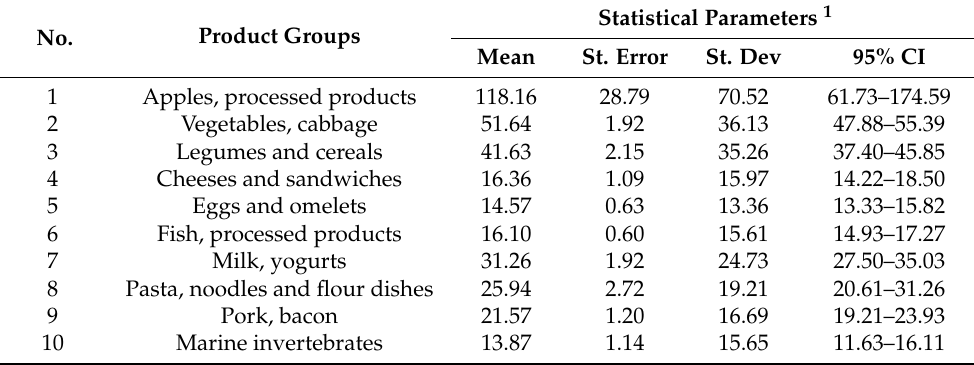
Table 4. ARP values calculated by the ANN for products and raw materials from different commodity